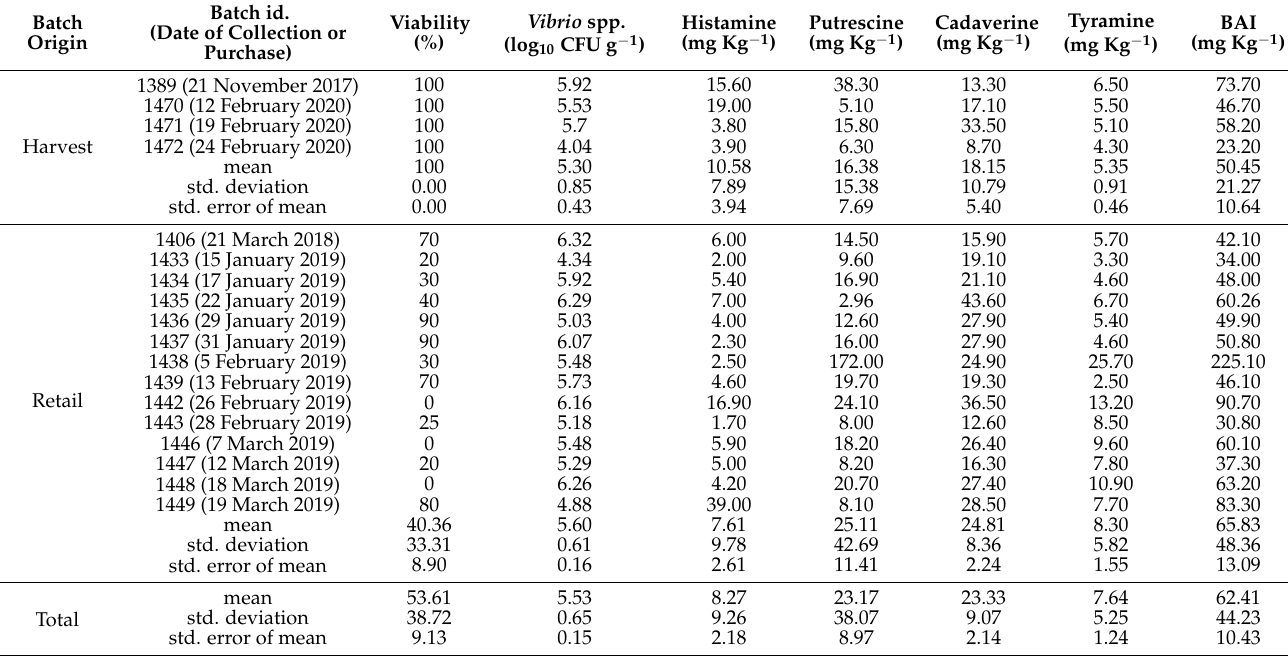
Table 2. Viability of the batches of Tritia mutabilis , Vibrio spp. load, single BAs content, and BAI (Histamine + Putrescine + Cadaverine + Tyramine) at harvest and at